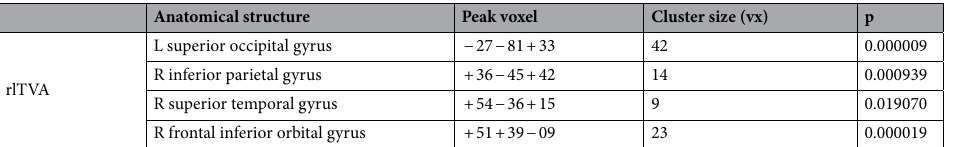
Table 2. Multi-voxel pattern analysis (MVPA). Overlapping clusters informative of both the rTVA and lTVA voice-preferential responses. Voxel-wise threshold was set to p < 0.001 and whole brain FWE-corrected at cluster level with a cluster threshold of p < 0.05. Voxel size 3 × 3 × 4 mm 3 . R right, L